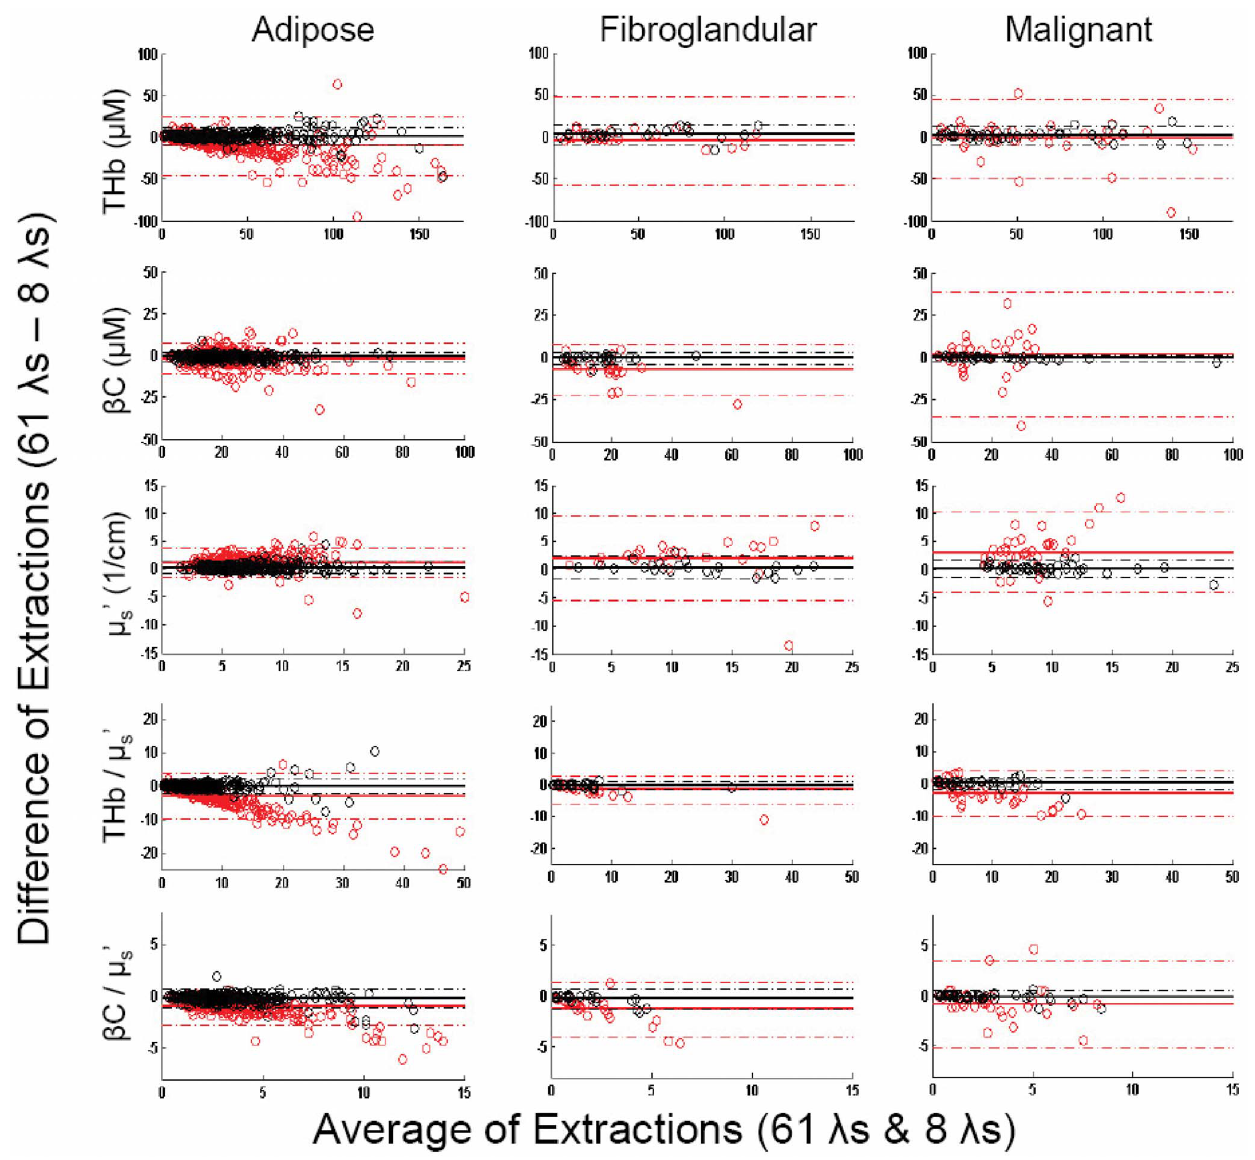
Figure 6. Bland-Altman plots of MC extractions using various wavelength combinations. Bland-Altman plots assessing the agreement of MC extractions of [THb], [ b c], , m s ’ . , [THb]/ , m s ’ . , and [ b c]/ , m s ’ . in adipose, fibroglandular, and malignant tissue types using the full spectrum versus the optimized reduced wavelength spectrum with 8 wavelengths (470, 480, 490, 500, 510, 560, 580, 600 nm) shown in black and the regularly spaced intervals (400, 420, 440, 470, 500, 530, 570, 600 nm) shown in red. The solid lines indicate the mean difference (bias) between the extractions; the dashed lines indicate the 95% limits of agreement.